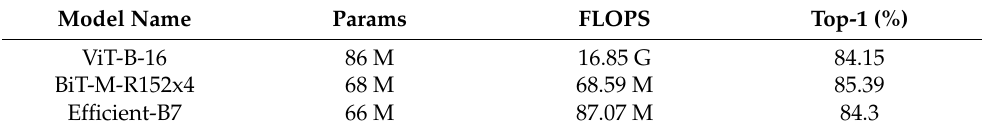
Table 1. Parameters count, FLOPS, and ImageNet Top-1 accuracy for ViT, BiT, and EfficientNet. The parameters and FLOPS are reported by “thop” library given an image of size 224 × 224 ×